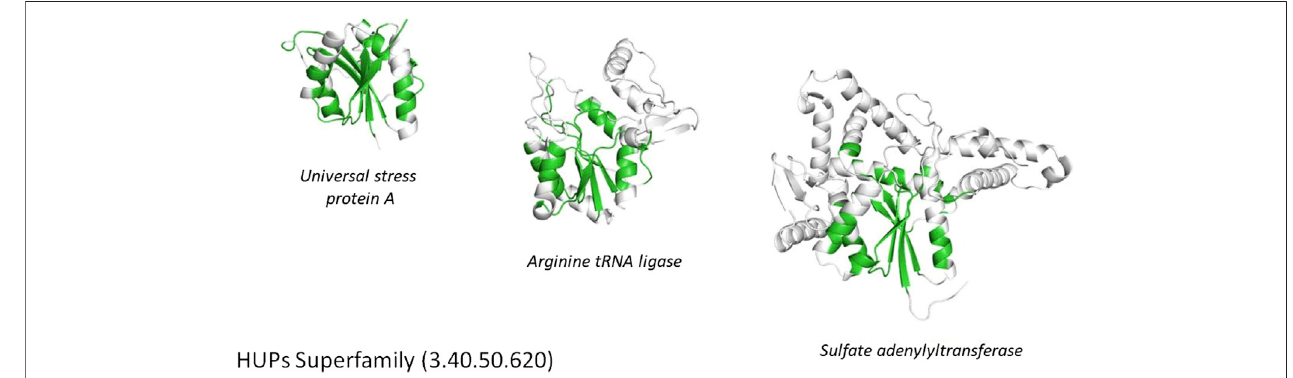
FIGURE 5 | Conservation of the structural core (highlighted in green) within the HUPs superfamily.